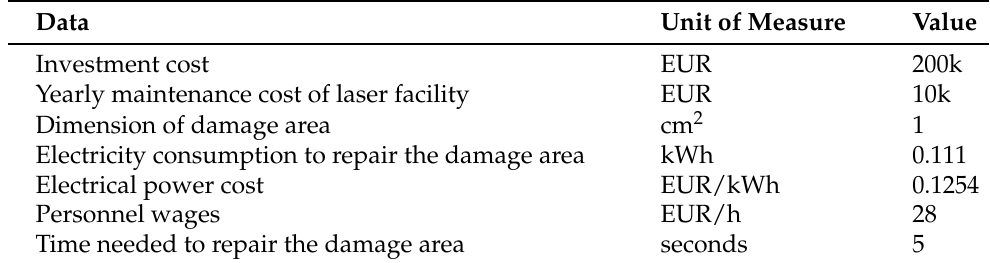
Table 11. Characteristics and cost of the repair technology. Electricity power cost were taken from [87]. Personnel wages data were taken from [88].